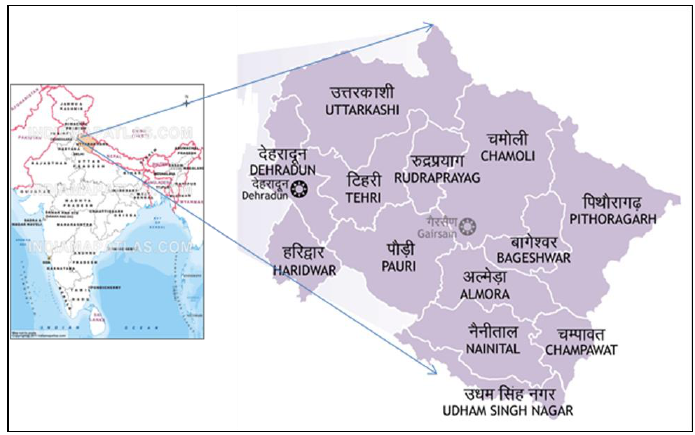
Fig.1. Location of study